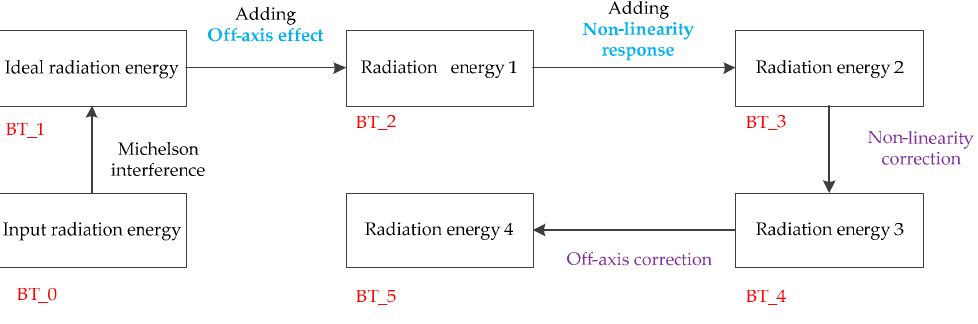
Figure 5. Flow chart of simulation process.